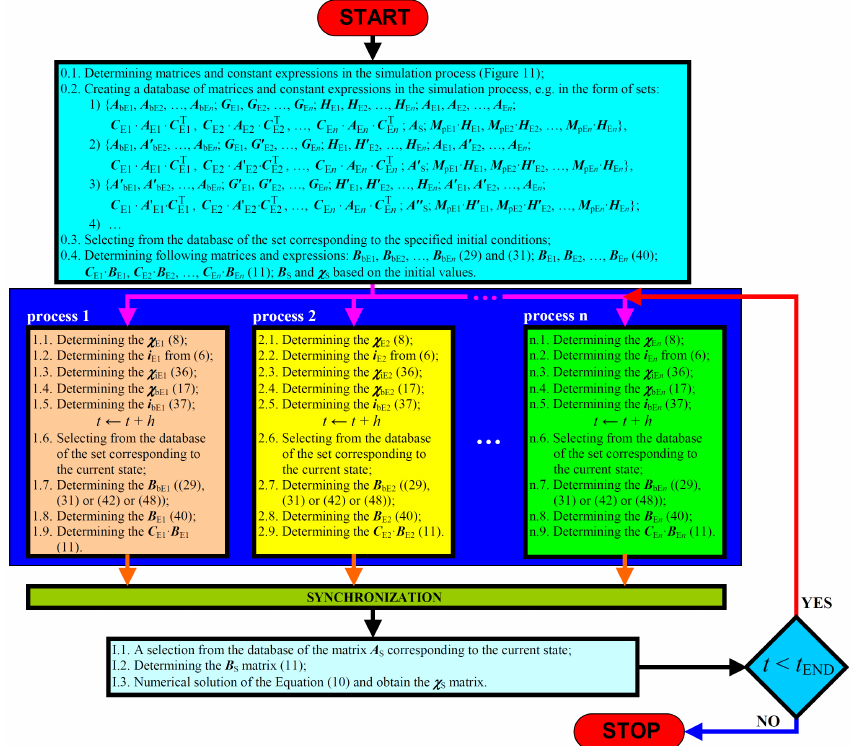
Figure 10. The example algorithm for the computer simulation of the operating states of the electrical system using the proposed theory with parallel